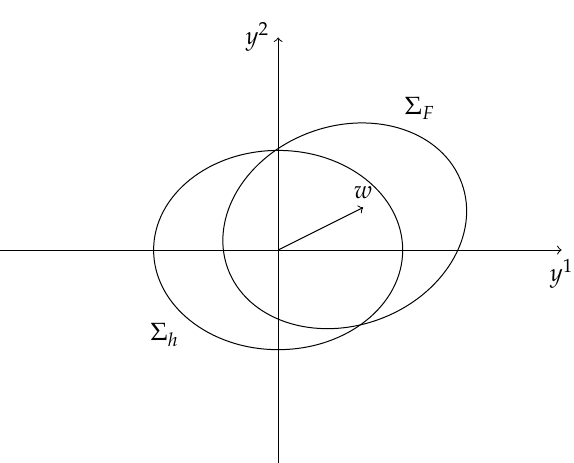
Figure 1. Randers metrics: a rigid displacement of an